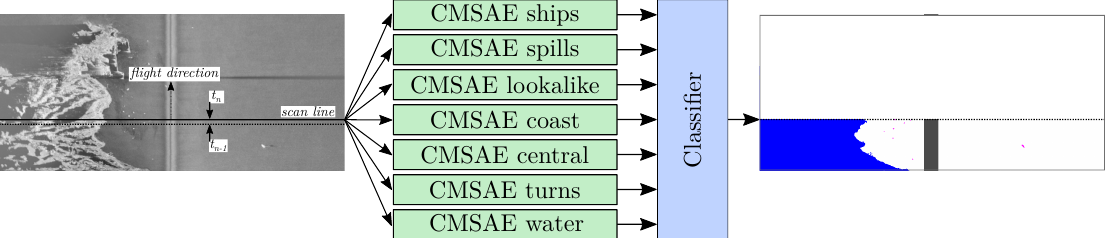
Figure 3. Architecture of the proposed network. Each scanline is supplied to a series of ConvLSTM Selectional AutoEncoders (CMSAE) networks to process each of the different classes in parallel. The results of these networks are given to a final classifier which performs the